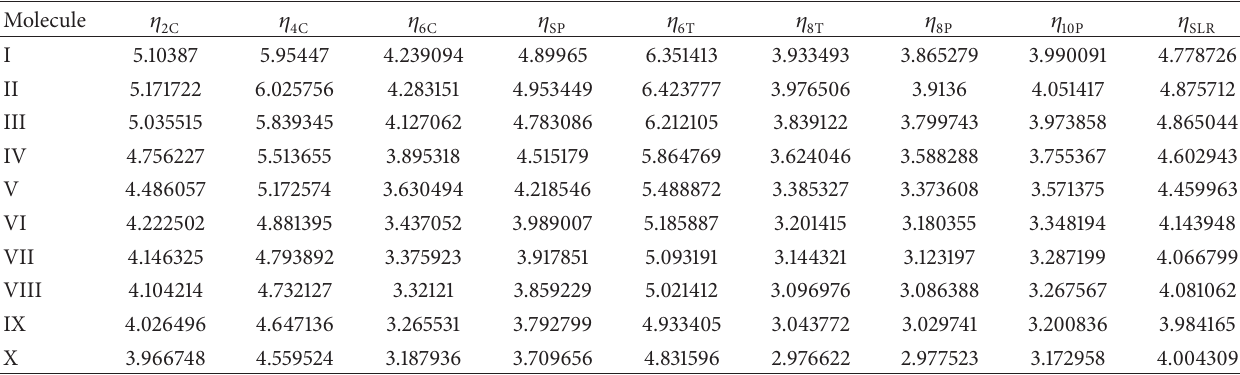
Table 4: Chemical hardness values (in eV) as computed for molecules of Table 2 with first-order LUMO(1)-HOMO(1) and second-order LUMO(2)-HOMO(2) gaps of (21) with parameters of Table